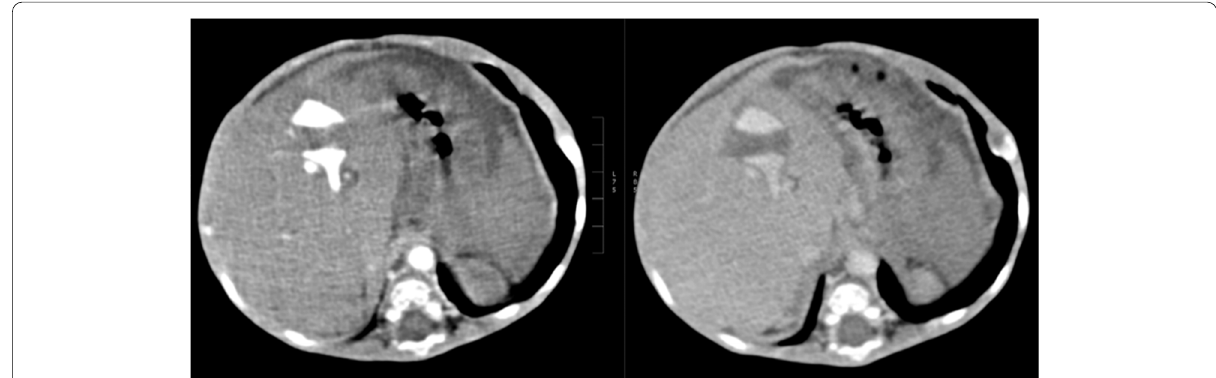
Fig. 1 Axial CT arterial and portovenous images through the right lobe of the liver showing a tubular structure with early arterial filling and portovenous filling